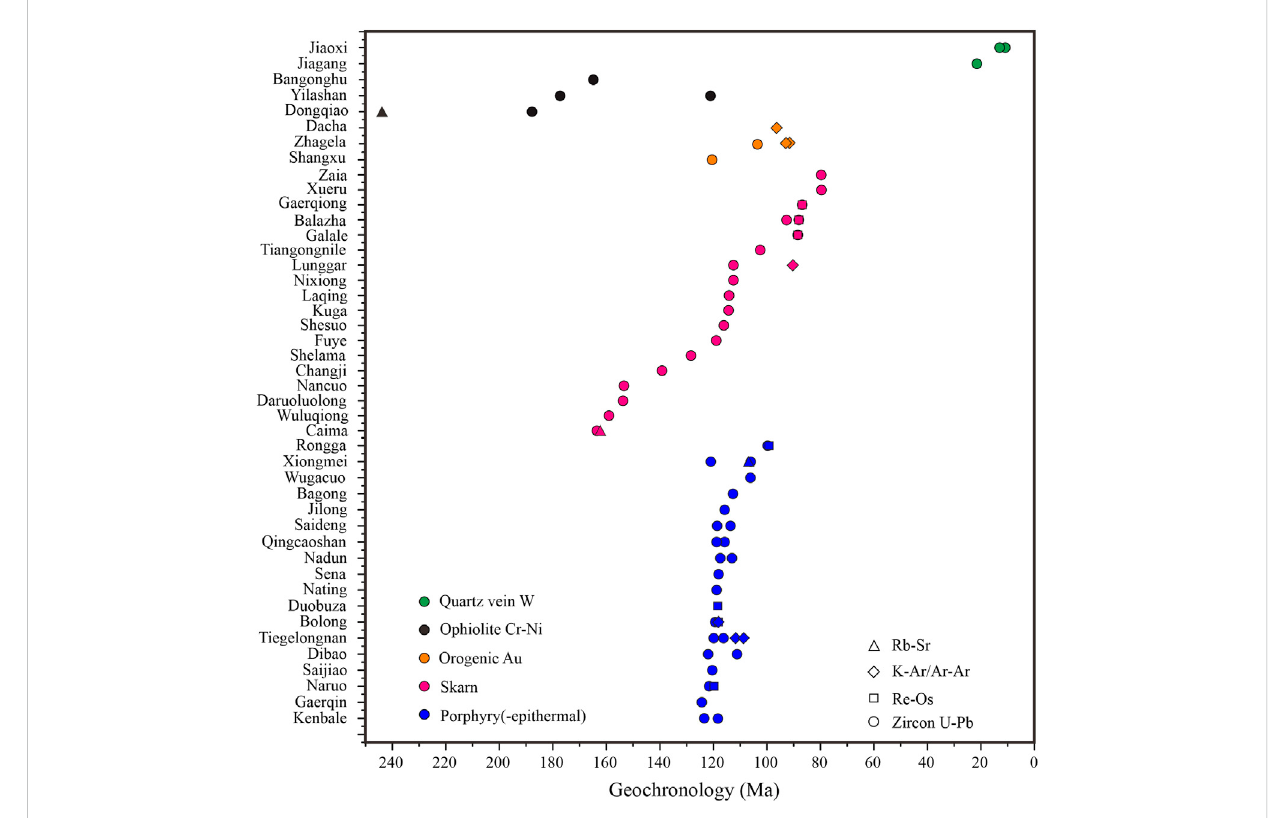
FIGURE 8 Geochronology of ore deposits in the Bangong – Nujiang metallogenic